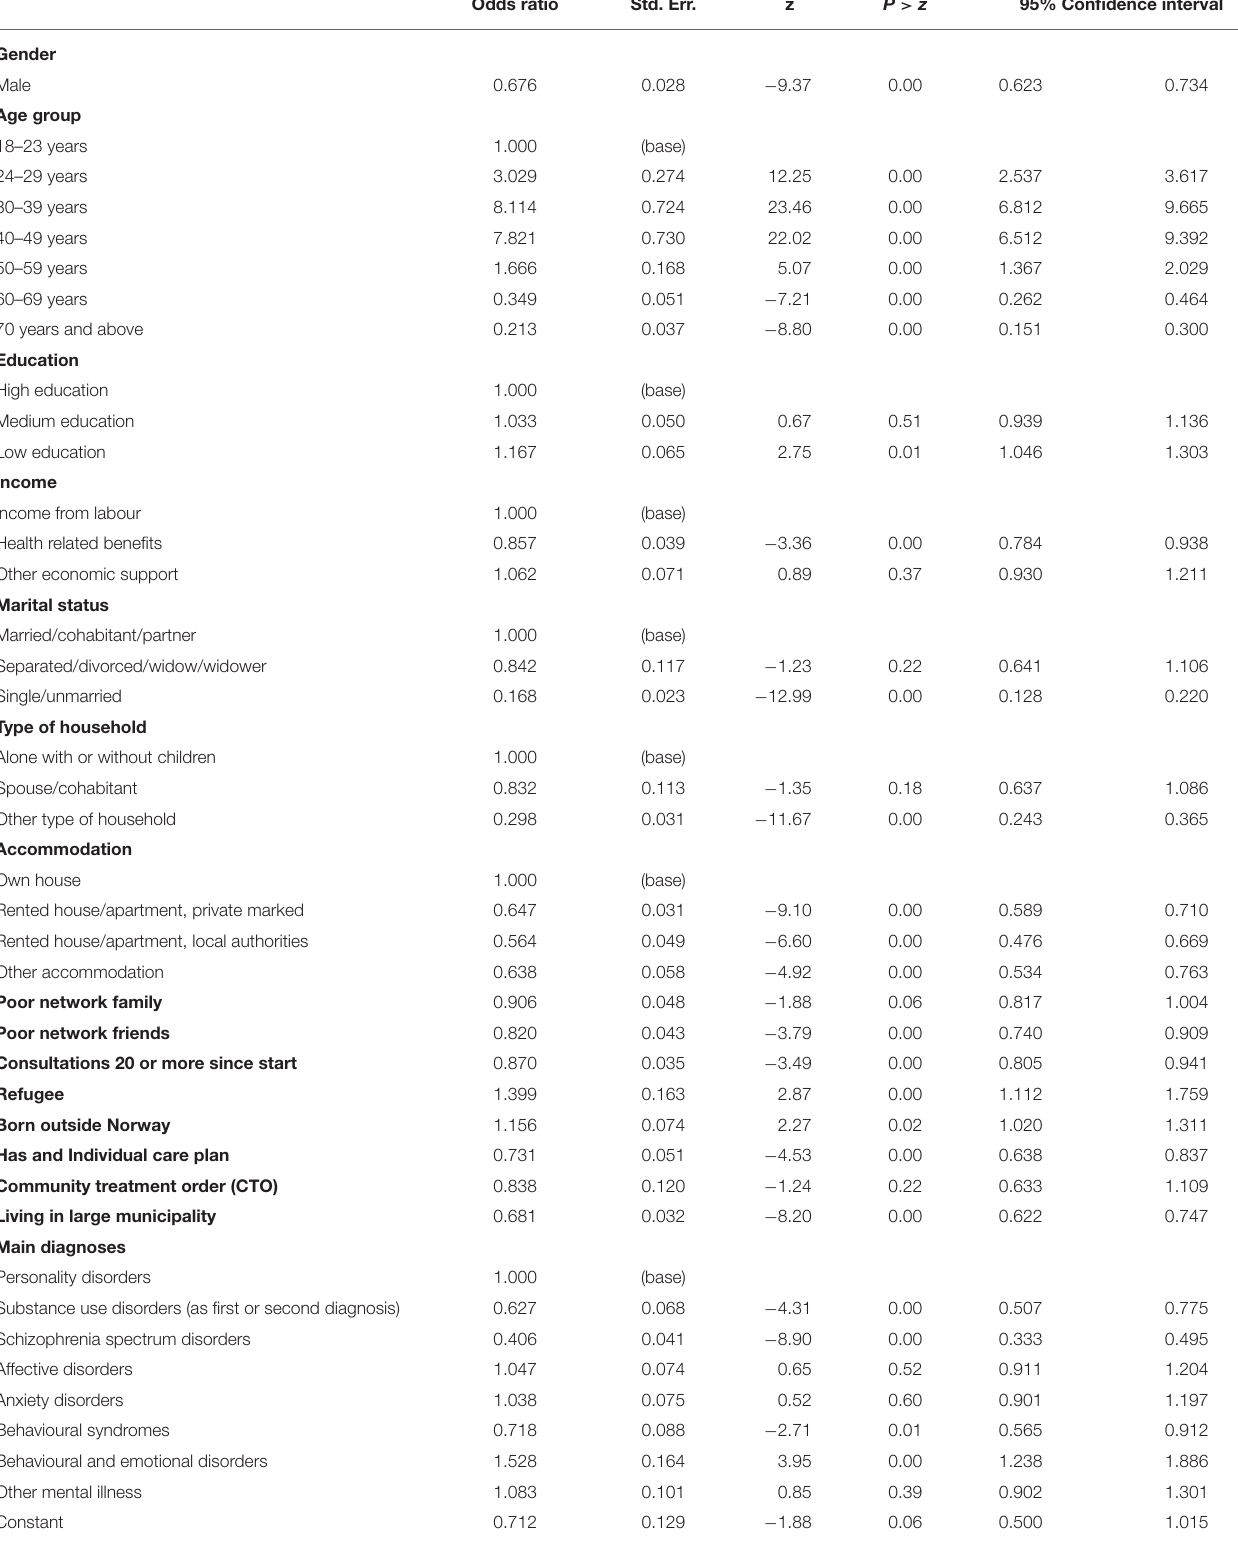
TABLE 3 | Logistic regression of the association between patient characteristics and whether the outpatients ( N = 22,847) care for children under 18. Odds ratio Std.